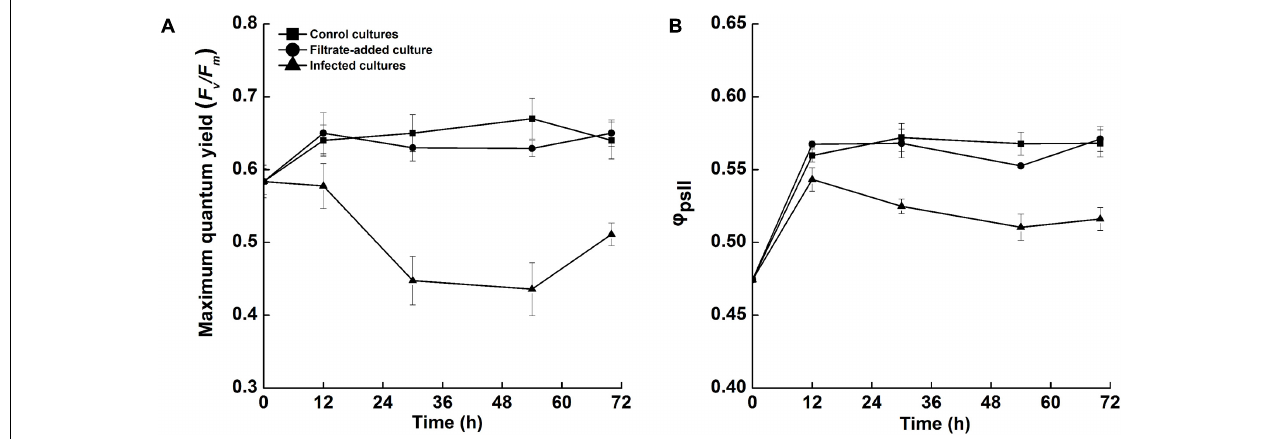
FIGURE 4 | Variations in the photosynthetic efficiencies of Akashiwo sanguinea during the course of infection by Amoebophrya sp. at a dinospore: host ratio of 10: 1. (A) F v /F m . (B) (cid:56) PSII . Error bars indicate the standard error.